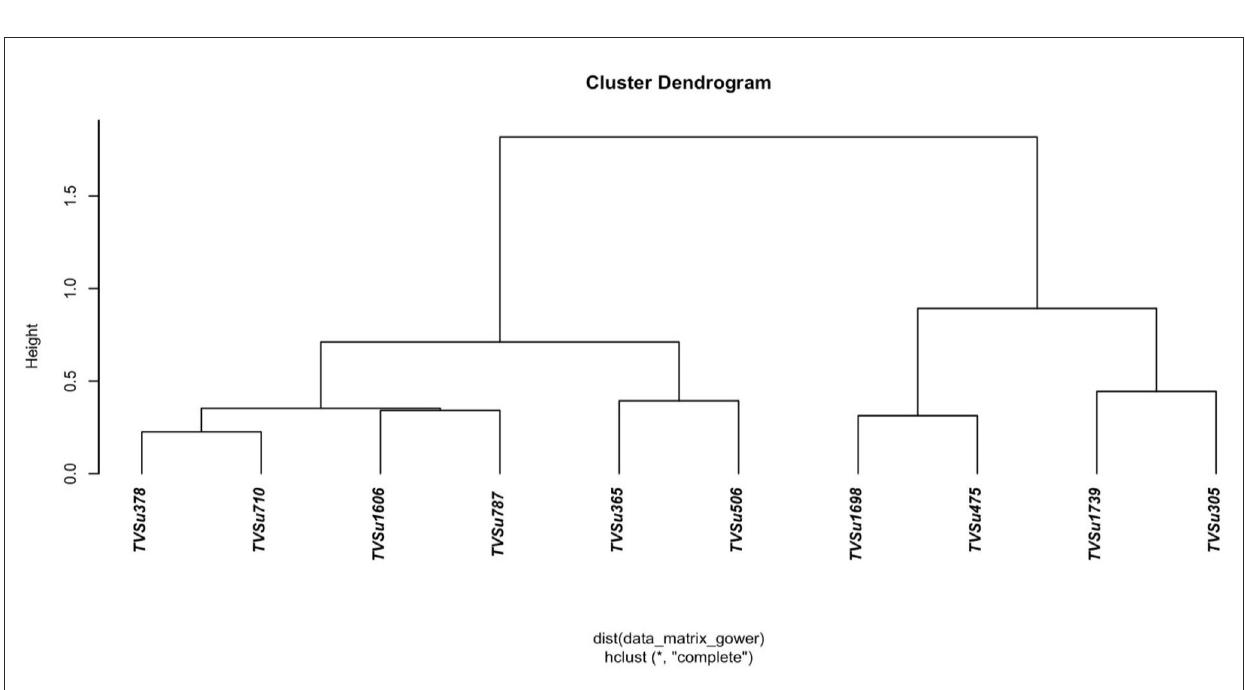
FIGURE2 Dendrogram showing the response of BGN genotypes to